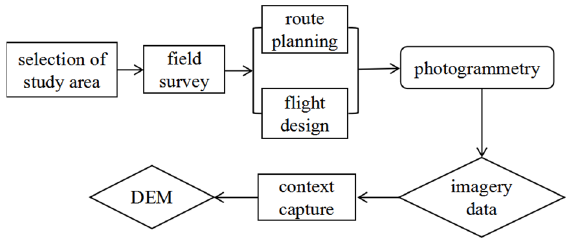
Figure 2. DEM data production process.